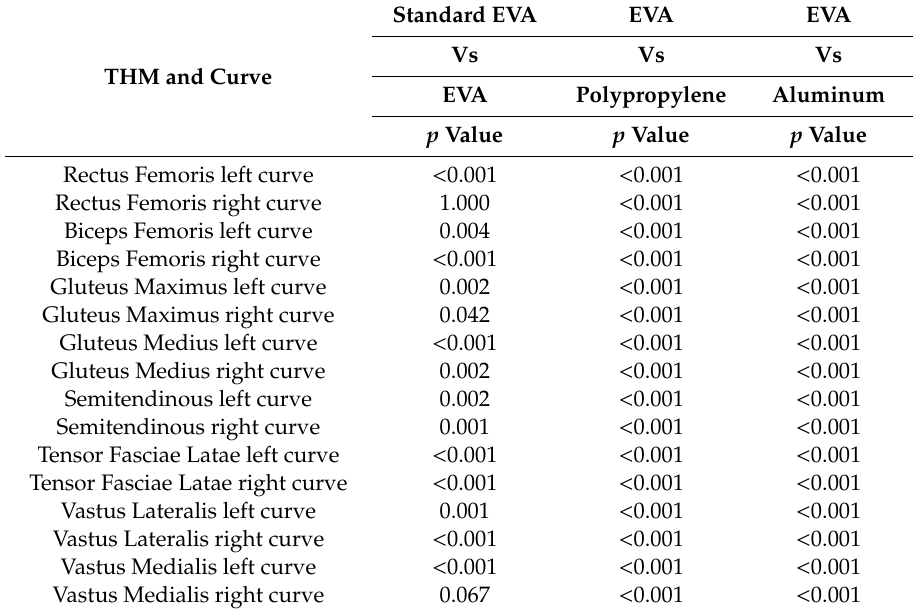
Table 5. Correlation between di ff erent kinds of hardness insoles with regard to EMG activity patterns of the Thigh and Hip